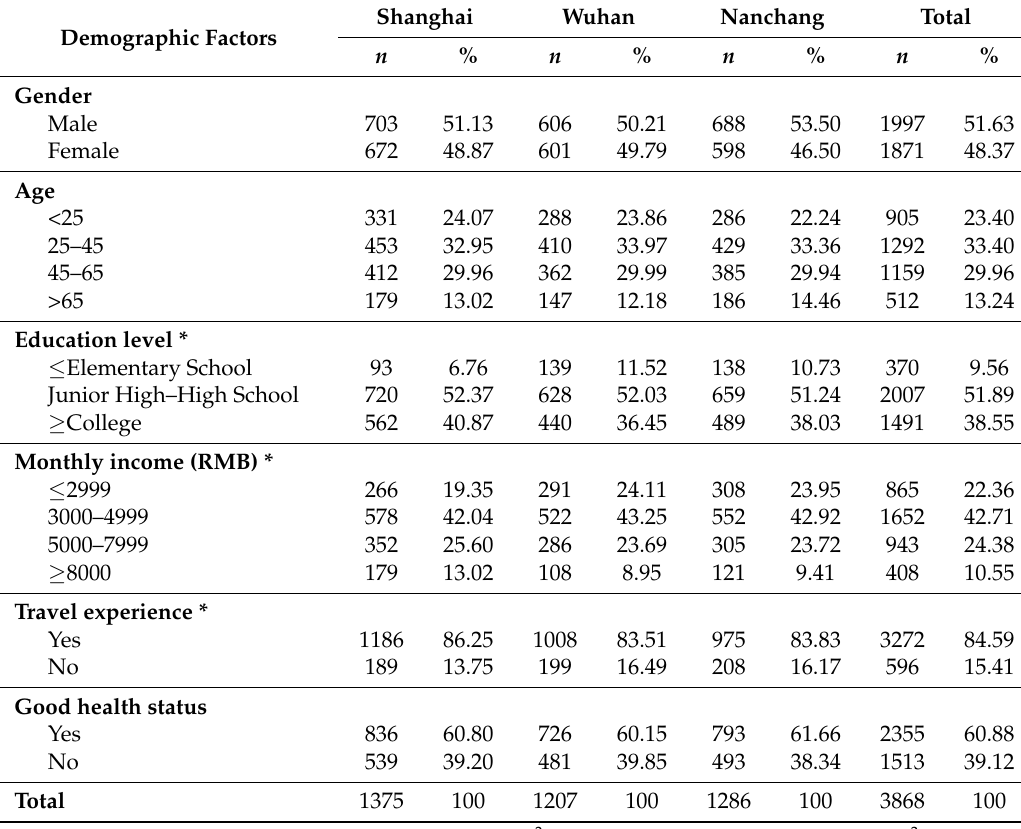
Table 1. Demographic information of the participants in three study sites ( n =